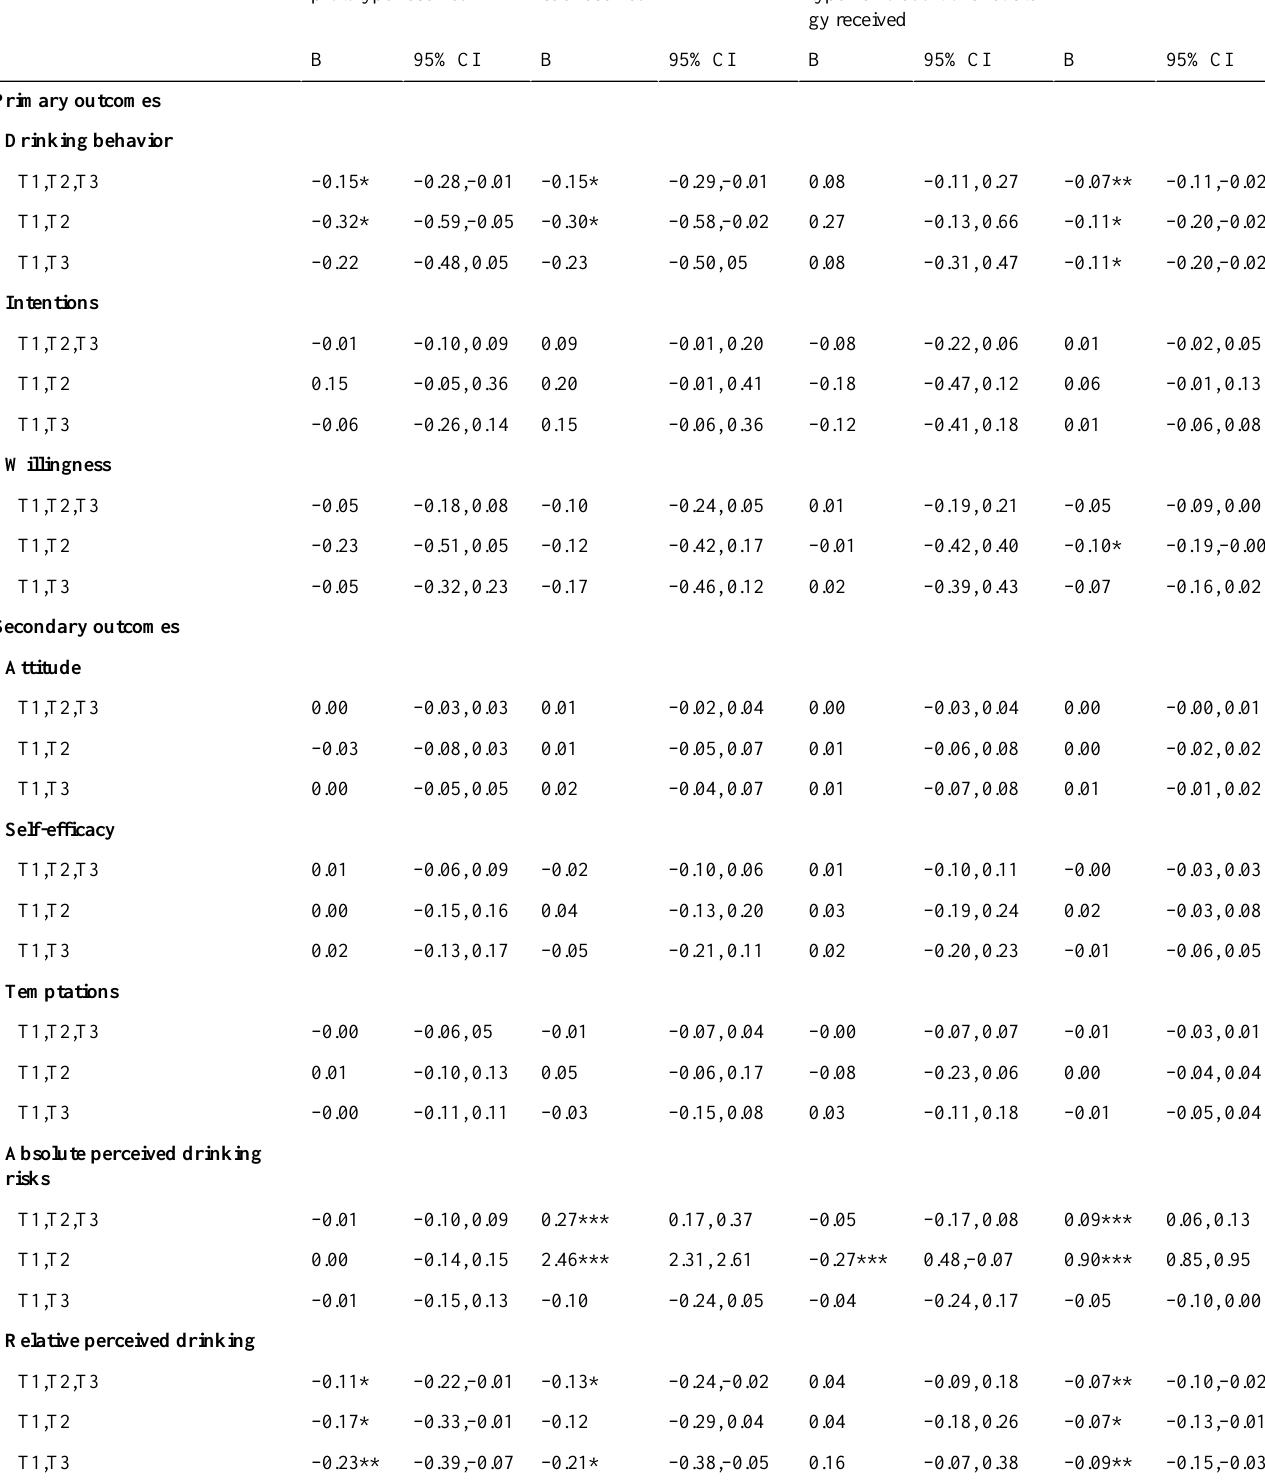
Table 4. Longitudinal multilevel analyses (mixed models) including analyses over all measurements (baseline, T1; 1-month posttest, T2; and 6-month follow-up, T3) and separately for short term (T1 to T2) and long-term measurements (T1 to T3), corrected for education and age. Regression coefficient (B) and 95% confidence intervals are presented regarding change over time for the strategy-added group versus no strategy added to the original Drinktest analyses